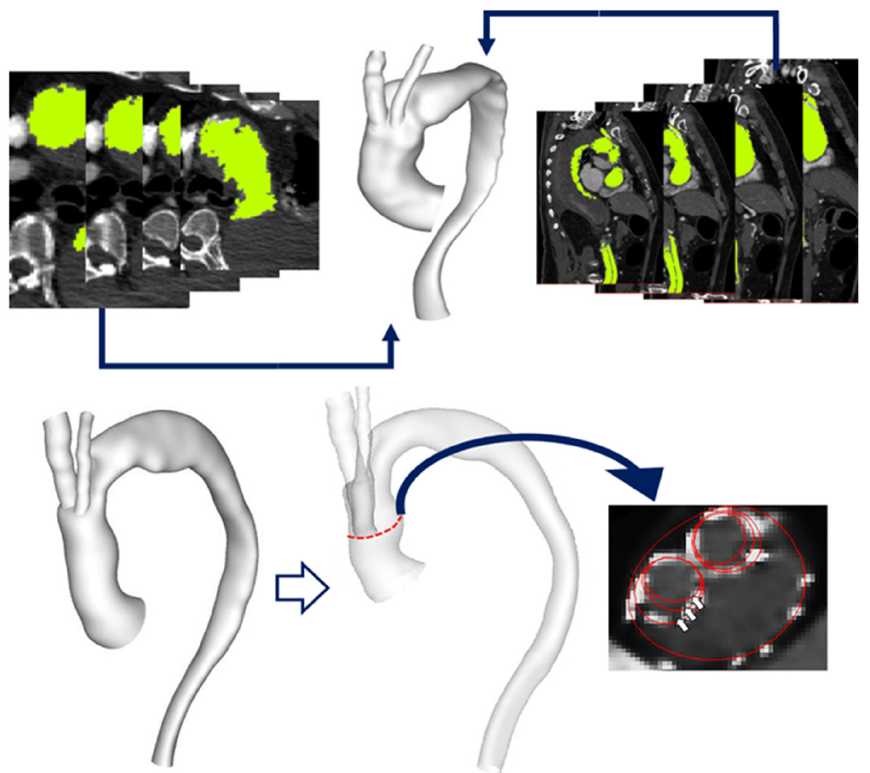
Figure 1. ( Top ) Multislice CT images used to generate anatomically accurate 3D reconstruction of the aortic arch. ( Bottom ) Reconstructed aorta model for Patient 1 with a transparent view indicating inner tunnel branches within the main endograft. The original inner tunnel branches are 12 mm in diameter and have been artificially modified to create models with branches of 10 mm and 8 mm diameter, respectively, as illustrated by the red outlines in a cross-sectional view of the ascending aorta, with the arrows indicating the three different branch diameters being investigated here.